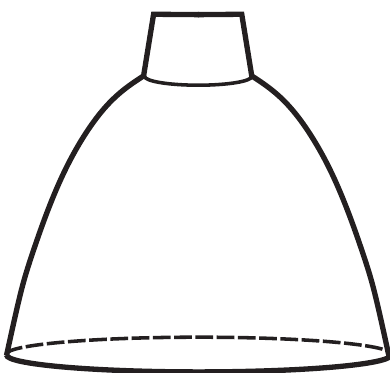
Figure 2. Schematic of a parabolic